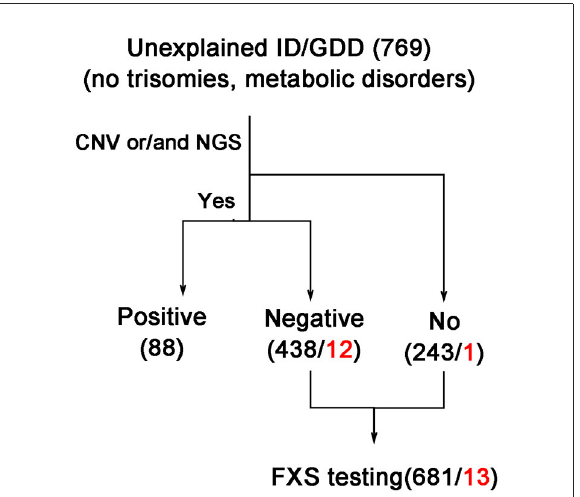
FIGURE1 Strategy of selection for individuals with ID/GDD who were tested by FXS testing. The black and red numbers indicate the total and positive numbers, respectively. CNV, copy number variations including chromosome microarray analysis and CNV-seq detection; ID/GDD, intellectual disability/global developmental delay; NGS, next-generation sequencing; including gene panel, clinical exome sequencing, and whole exome sequencing examination.